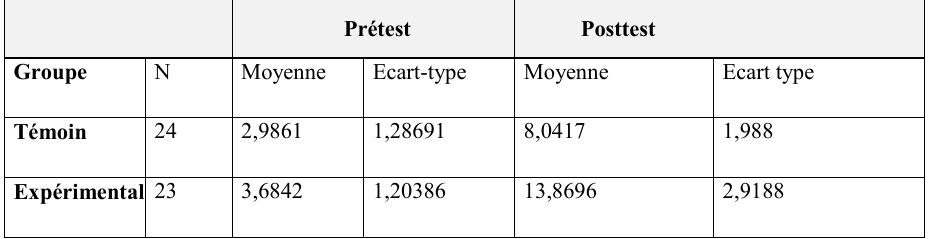
Tableau 3 : Résultats des statistiques descriptives.